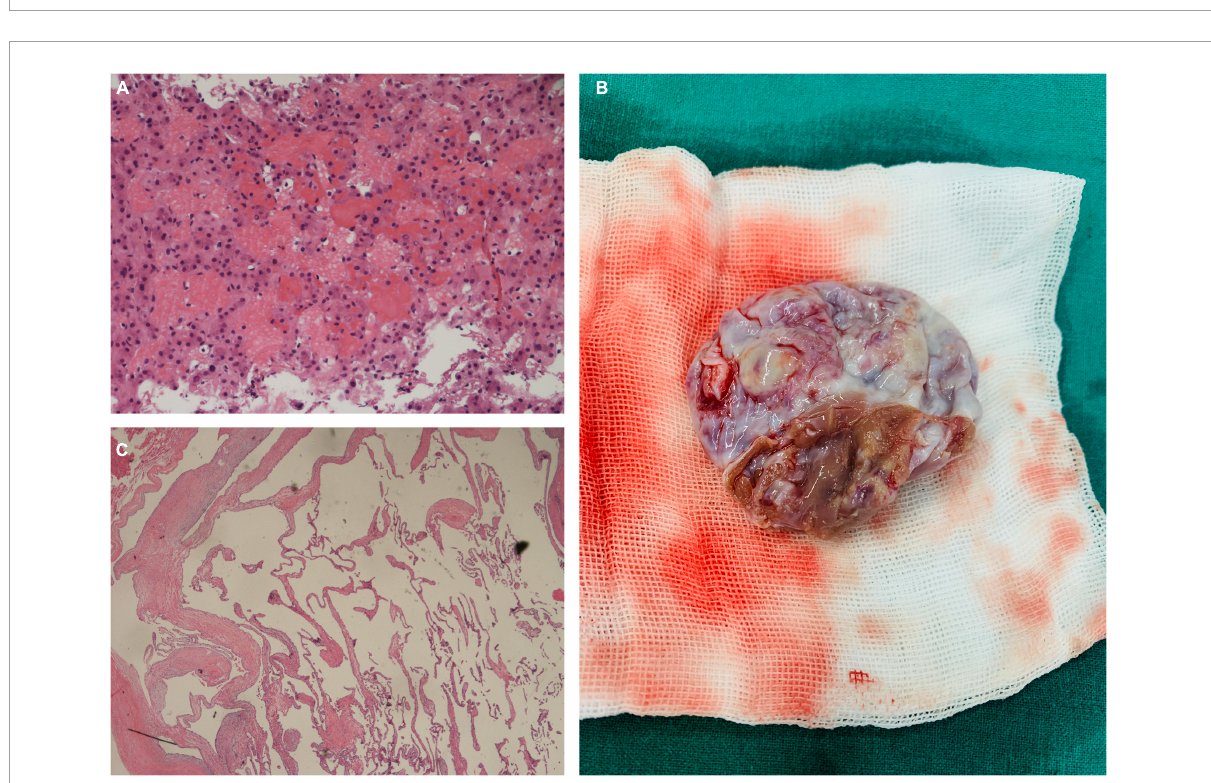
FIGURE2 (A) Pathological examination of the liver mass showing multiple irregular dilatated vascular spaces and layers of endothelial cells without signs of malignancy (Hematoxylin and eosin, × 200). (B) Intraoperative photograph of the excised specimen appeared as a cystic mass with a broad base and intact capsule. (C) Pathological evaluation of the cardiac mass (Hematoxylin and eosin, ×